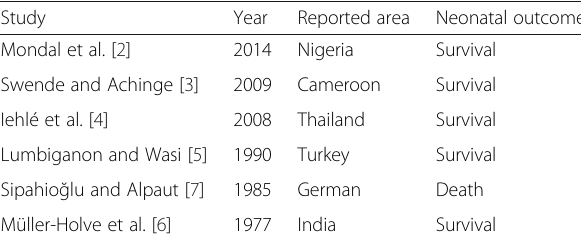
Table 1 Reported rabies cases in pregnant women